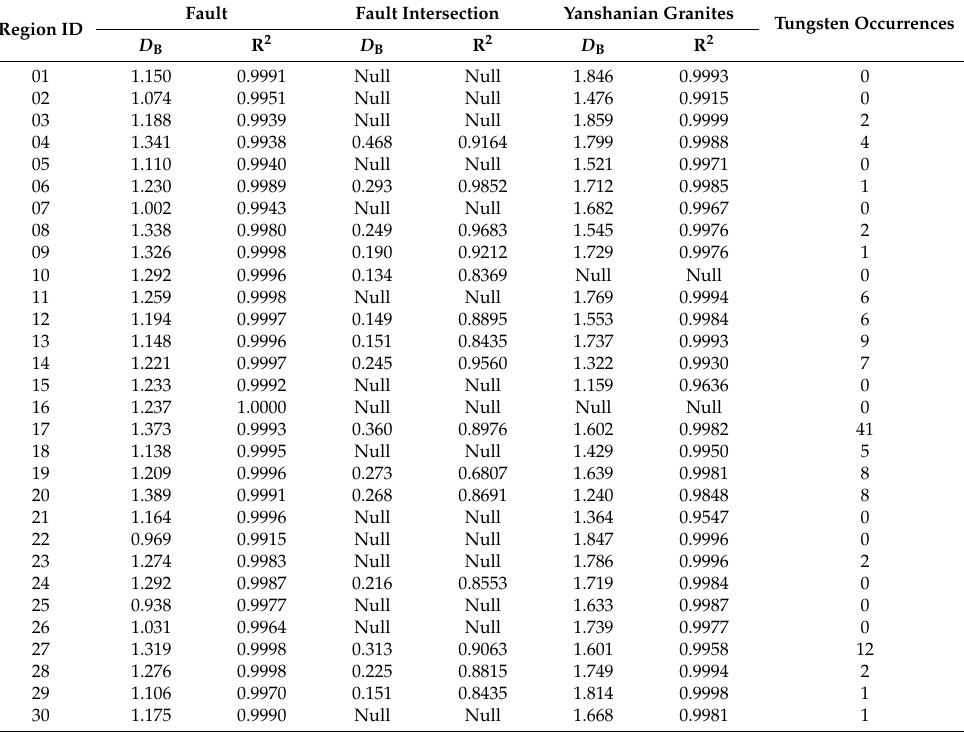
Table 1. Result of box-counting fractal analyses of geological